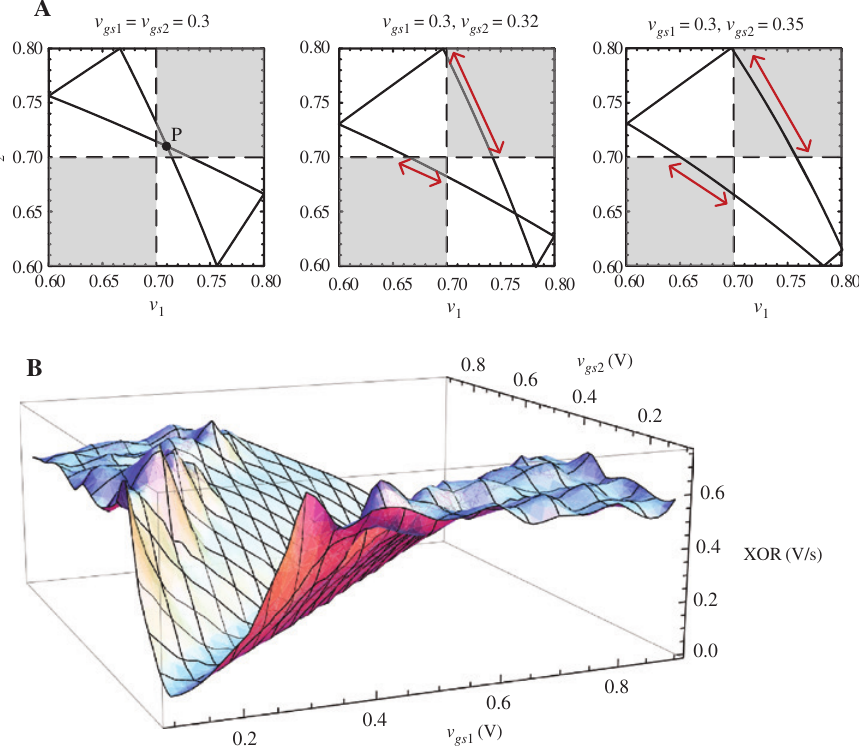
Figure 4: (A) Relationship between XOR output and the steady-state periodic orbit of the system. At any instant of time, XOR output is 1 in the grey region and 0 otherwise. Averaged XOR output is equal to the fraction of time spent by the system in the grey regions. XOR output is minimum in case of a butterfly-shaped orbit (left) and should increase as the orbit transitions to a rectangular orbit (right). (B) XOR surface as a function of v and v gs 1 gs 2